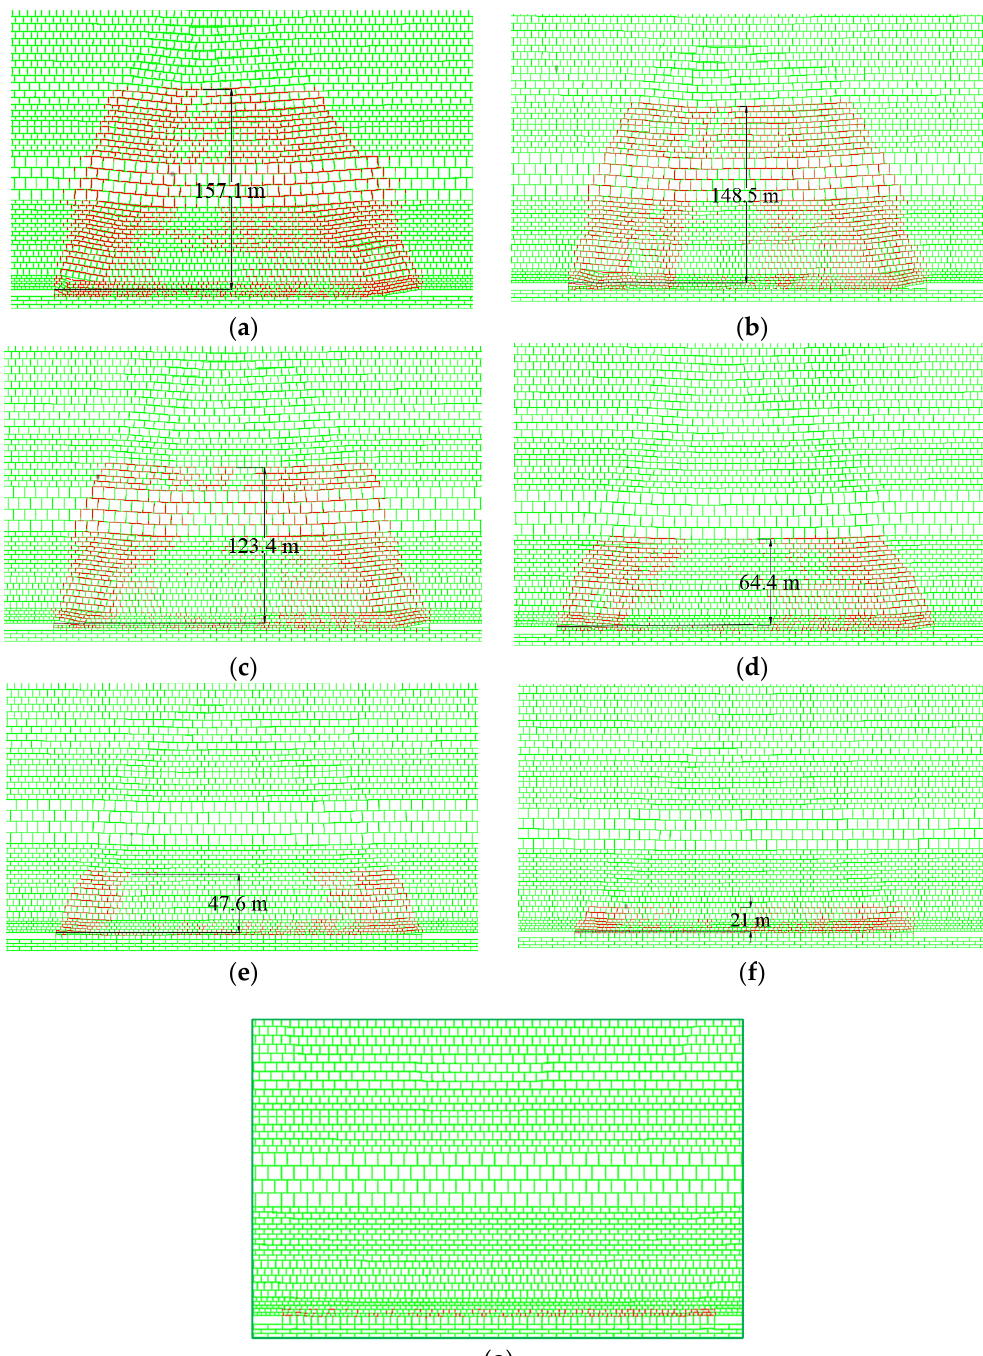
Figure 10. The development characteristics of overlying strata fractures under different filling ratio conditions. ( a ) Un-filling; ( b ) Filling 1/5; ( c ) Filling 1/3; ( d ) Filling 1/2; ( e ) Filling 2/3; ( f ) Filling 3/4; ( g ) Filling 100%.